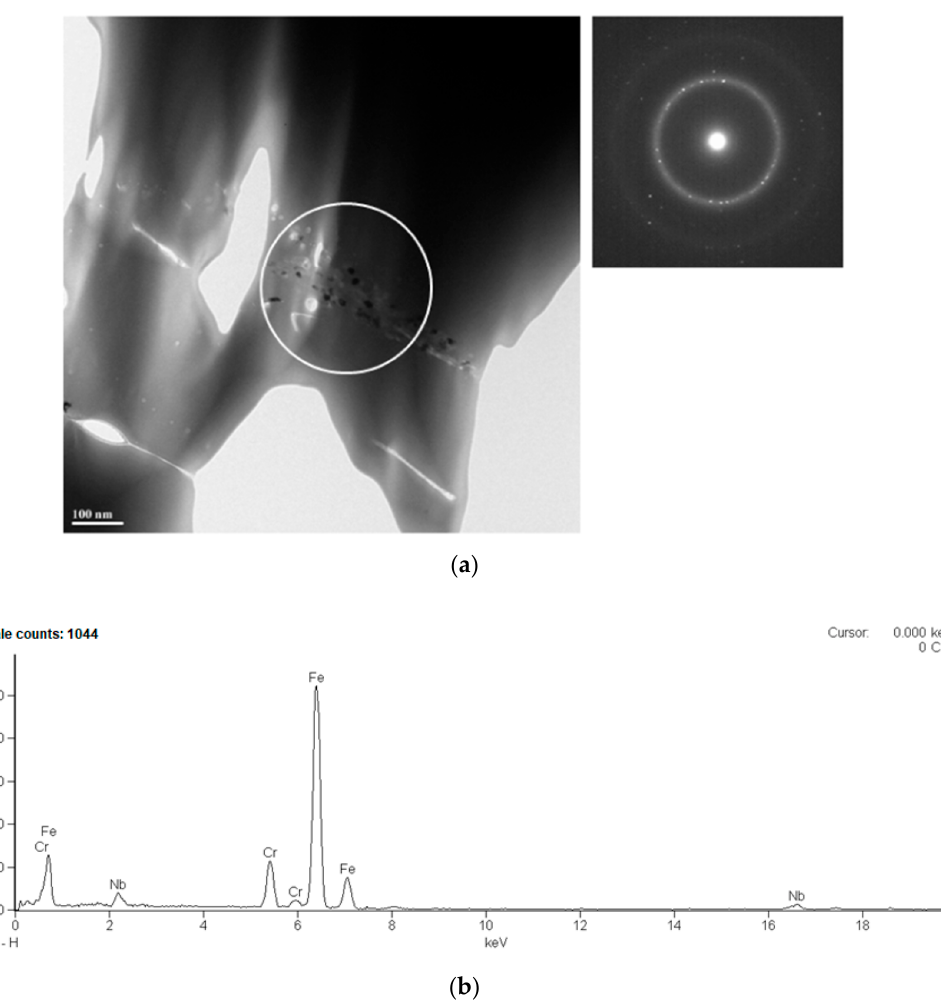
Figure 8. TEM image of the detonation coating structure showing nanocrystals found occasionally at the inter-splat boundaries and a corresponding SAEDP ( a ), elemental analysis results of the nanocrystals ( b ). Explosive charge 60%.